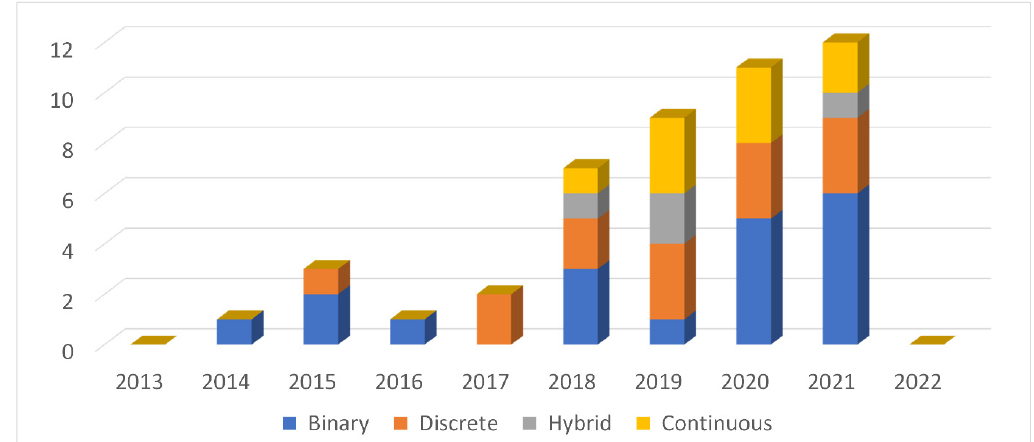
Figure 6. Distribution of single zone works by Tier 2 categories.